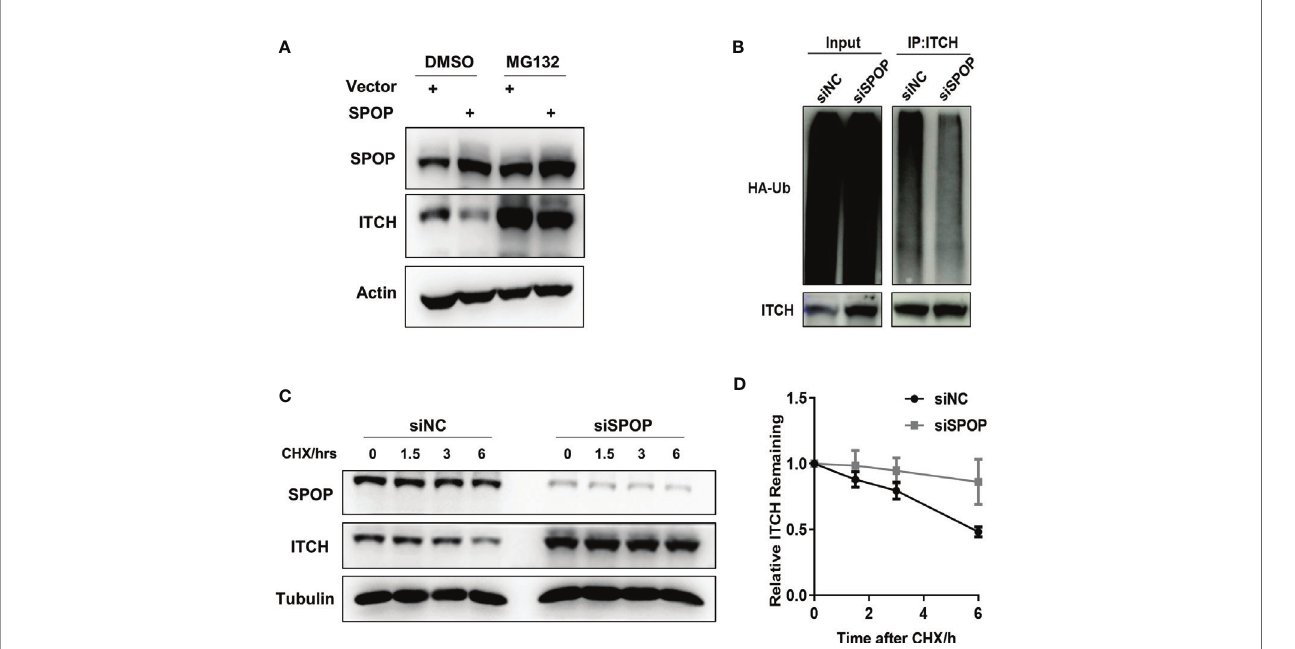
FIGURE 2 | SPOP is required for ITCH ubiquitylation and it suppresses ITCH stability. (A) LN-CaP cells transfected with either vector or HA-tagged SPOP were treated MG132. Protein levels were detected by Western blot using indicated antibodies. (B) The ubiquitylation assay of ITCH in the presence or absence of SPOP. HEK293 cells were co-transfected with HA-ubiquitin and the control or SPOP siRNAs. Endogenous ITCH was immunoprecipitated and immunoblotted with the anti HA or ITCH antibody . (C) SPOP knockdown increased the half-life of ITCH protein. CHX, cycloheximide. (D) Quanti fi cation of three independent experiments performed in